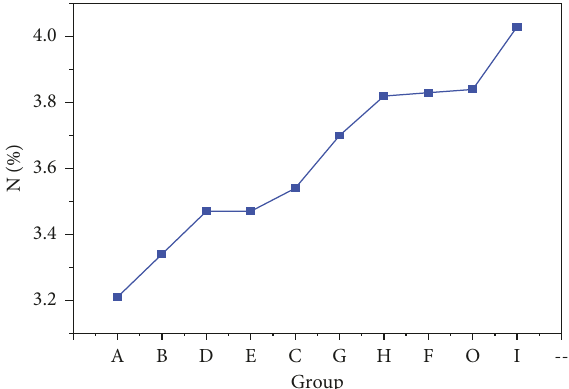
Figure 2: Percentage content of total nitrogen in leaves of 10 groups of